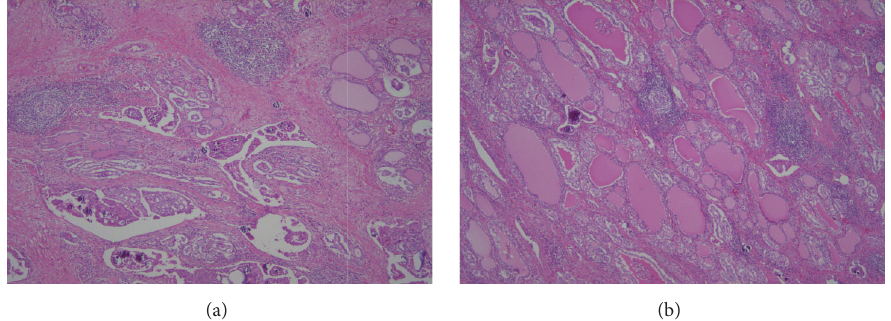
Figure 3: Microscopically, diffusely scattered tumor aggregates, extensive fibrosis, marked lymphocytic infiltration with formation of lymphoid follicles, and abundant psammoma bodies (a) were evident against a background of Hashimoto’s thyroiditis (b) (Hematoxylin & Eosin stain × 40).